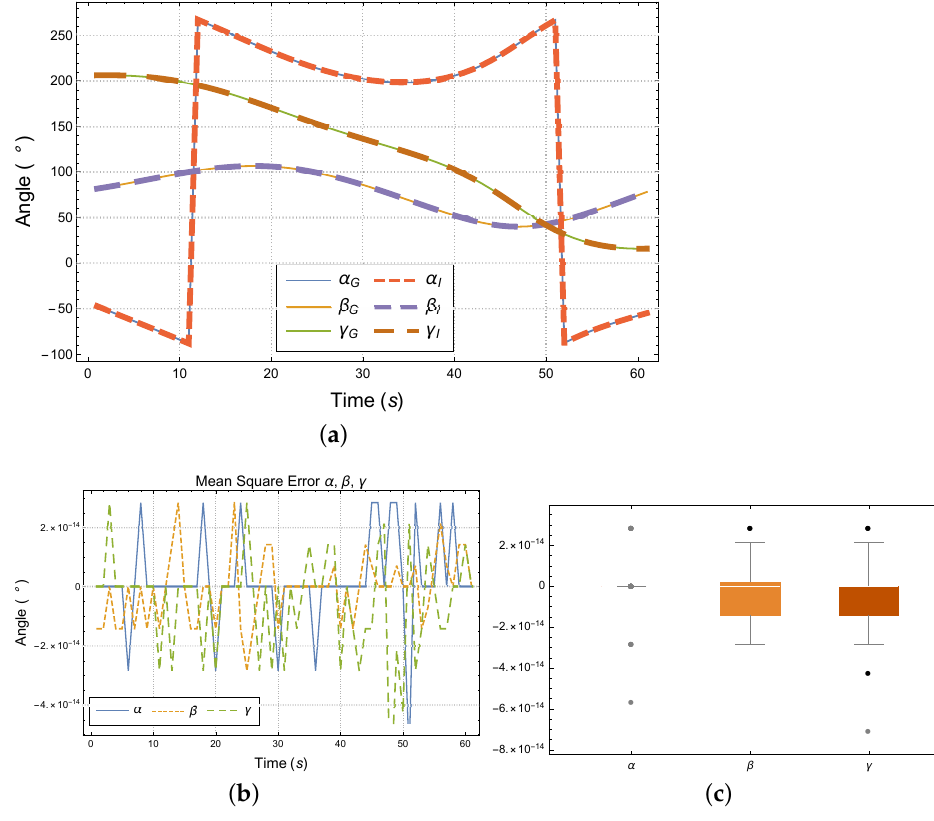
Figure 6. A comparison of the mathematical models of the orientation analysis. ( a ) Comparison of the orientation ( α , β , γ ) between CAD mechanical design and orientations equations. ( b ) Mean Square Error of the orientation. ( c ) Box plot of the